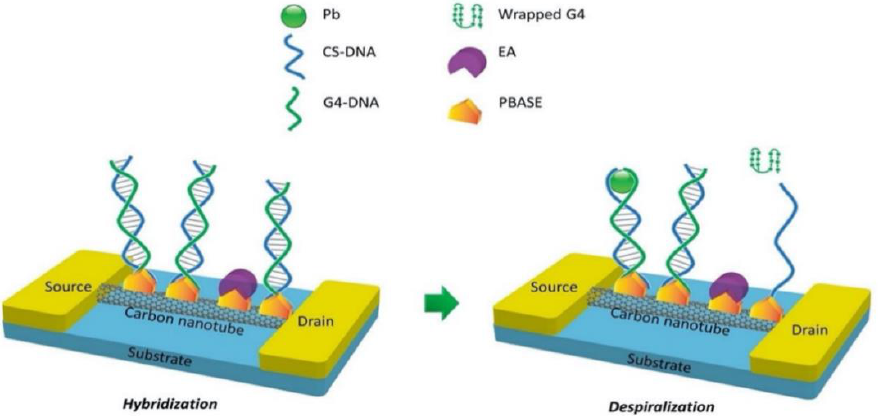
Figure 13. Hybridization and desalinization of CNT-FET sensors induced by G4-DNA and CS-DNA. Reproduced from Wang et al. [209] by permission of Elsevier Science Ltd.